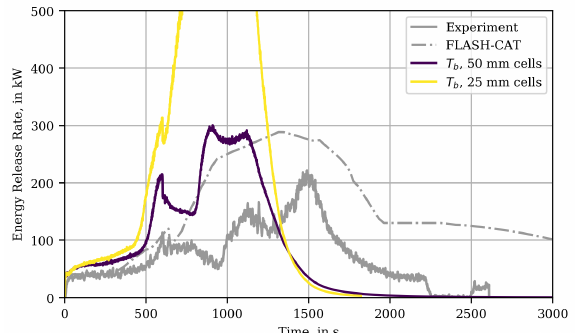
Figure A6. MT3 simulation results for the best parameter set of IMP run T b for with cell sizes of 50 mm (original setup) and 25 mm. The peak of the simulation with 25 mm cells is located at about (958.0 s, 975.3 kW).